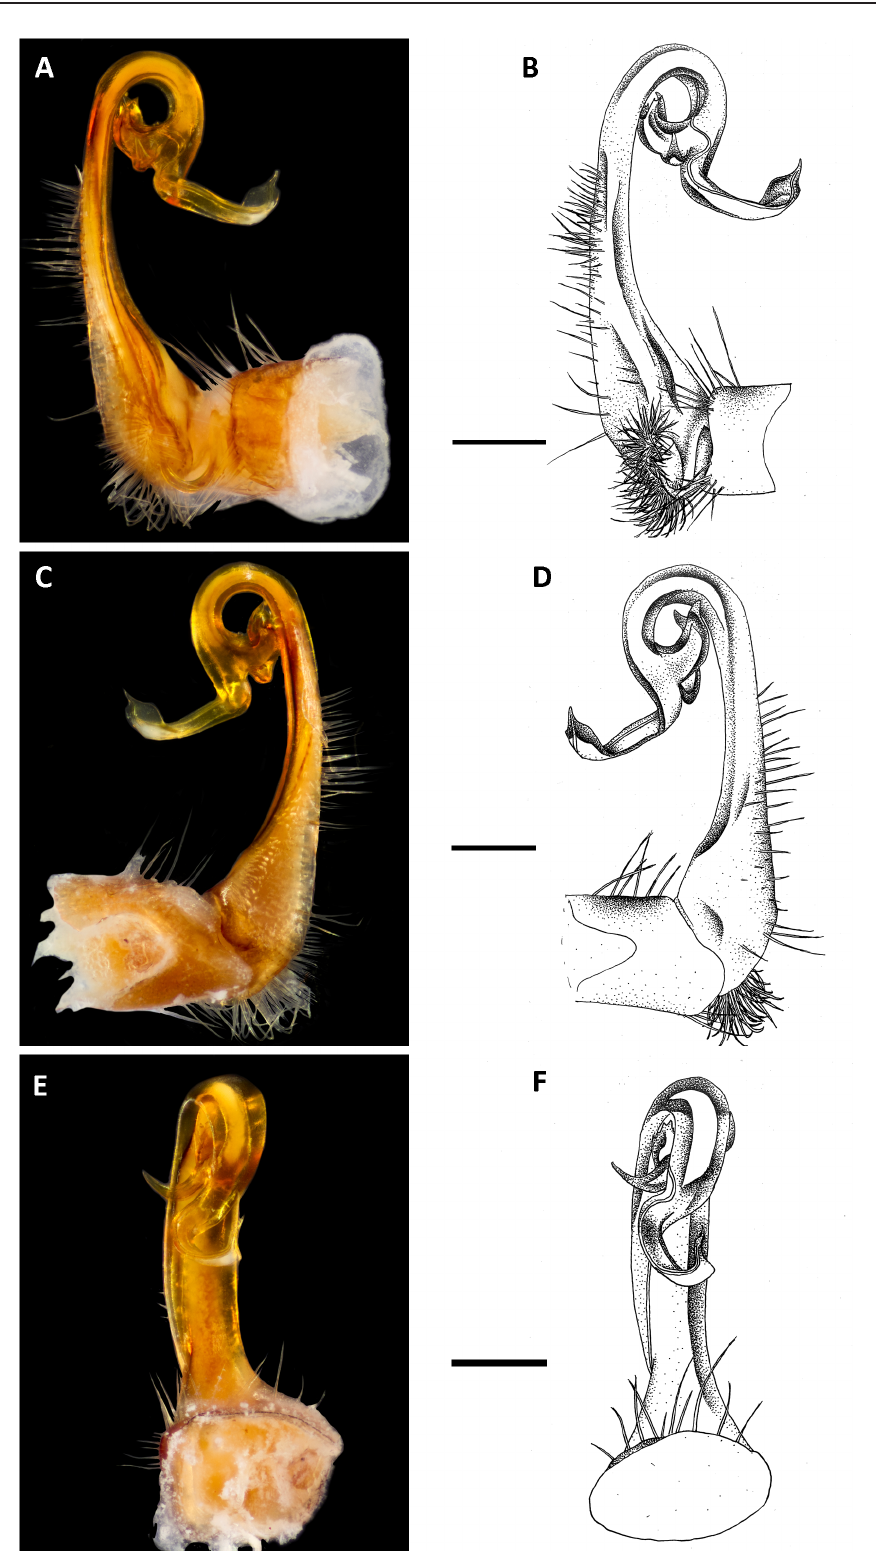
Fig. 19. Agrophogonus mwanihana Hoffman, 2005, specimen from Udzungwa Mts National Park, Sanje Kati camp & plot (NHMD 621682), right gonopod. A–B . Mesal view. C–D . Lateral view. E–F . Dorsal view. Scale bars: 0.5